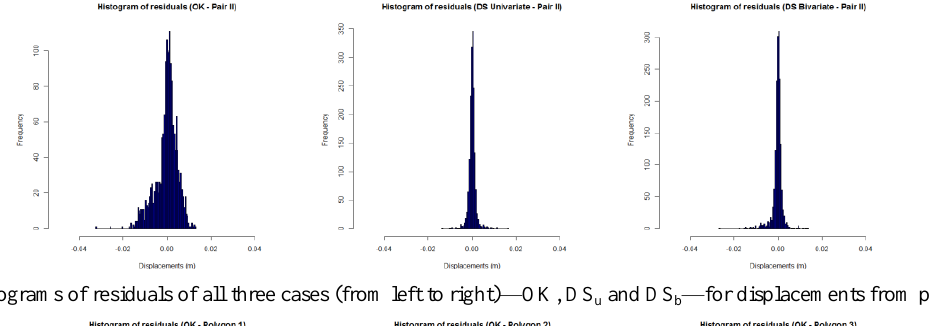
u and DS b —for displacements from pair II